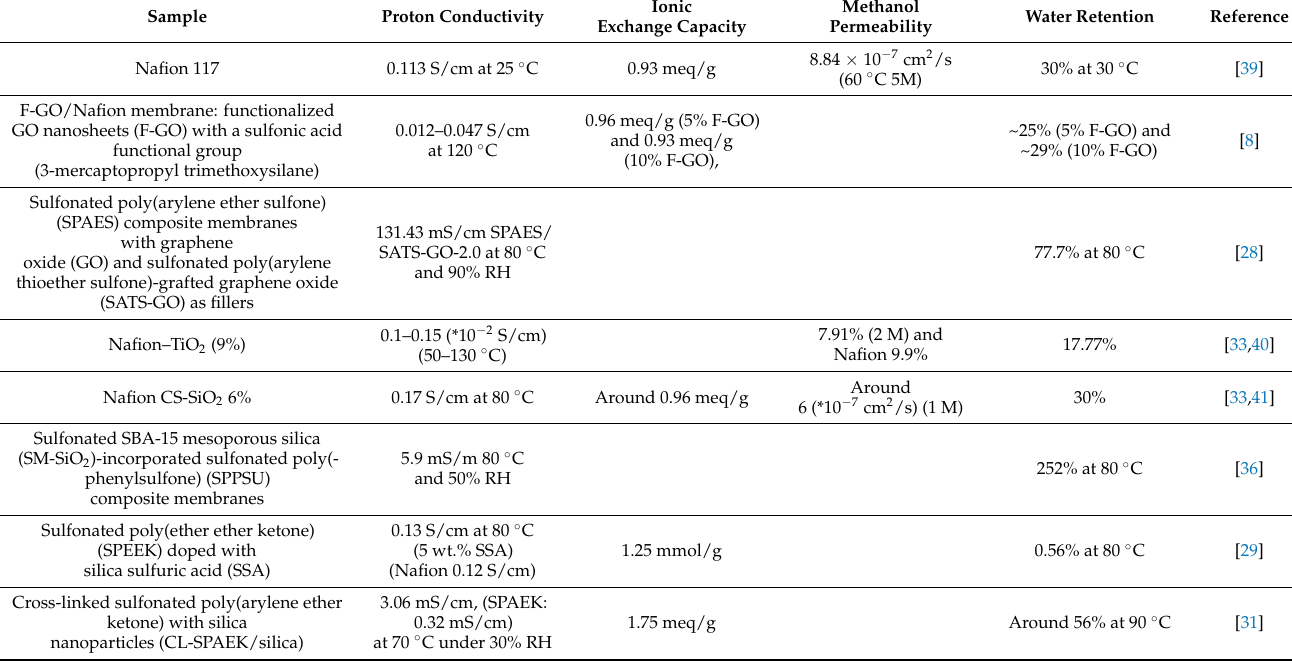
Table 1. Summary of the properties of some composite membranes reported in previous